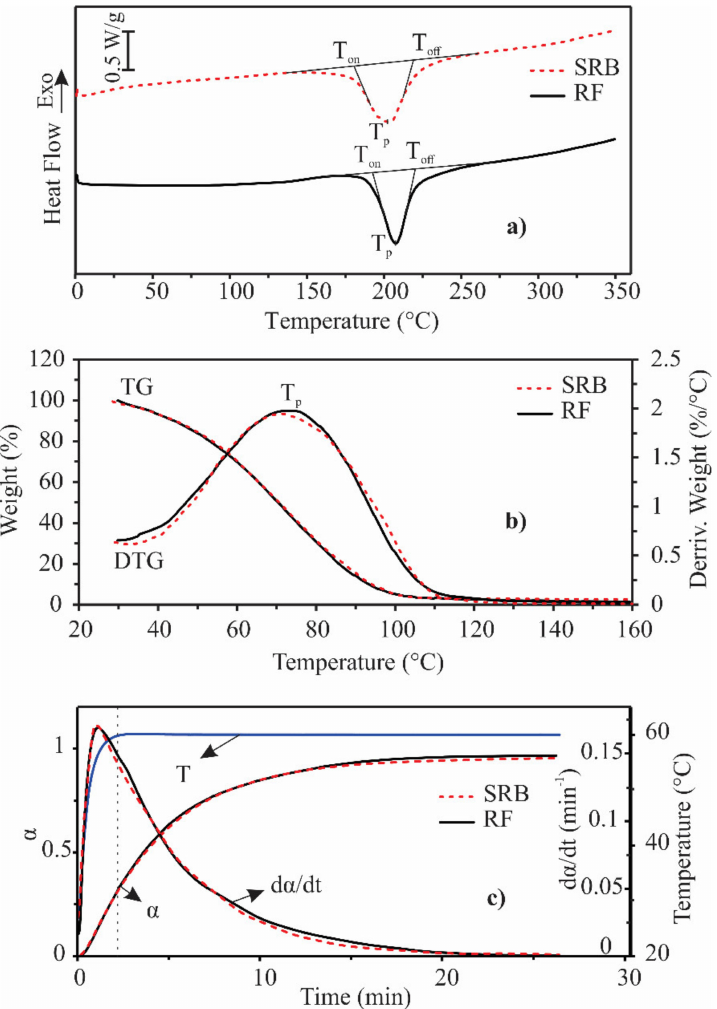
Figure 1. ( a ) DSC and ( b ) TG/DTG curves of Russian (RF) and Serbian (SRB) rosemary essential oils in non-isothermal condition at heating rate of 5 ◦ C/min; ( c ) degree of conversion ( α ), evaporation rate (d α /dt) and temperature (T) as a function of time in isothermal condition at 60 ◦ C for RF and SRB rosemary essential oils (beginning of isothermal conditions is marked by a vertical dashed